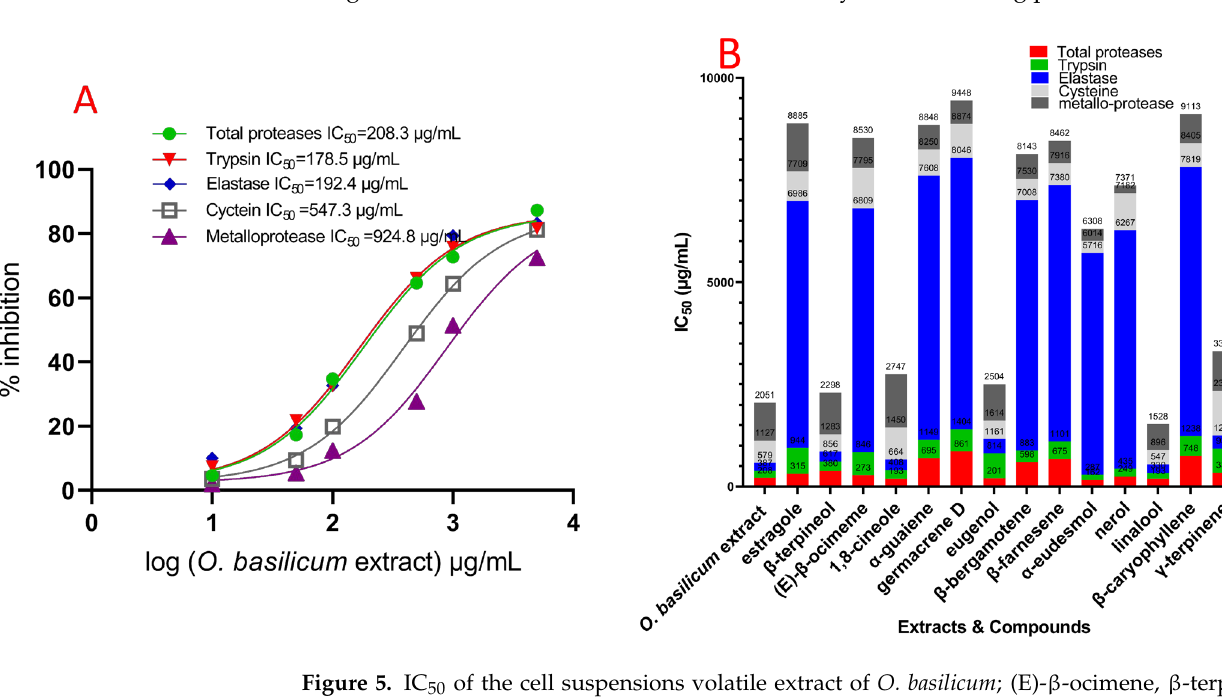
Figure 5. IC 50 of the cell suspensions volatile extract of O. basilicum ; (E)- β -ocimene, β -terpineol, estragole, 1,8-cineole, α -guaiene, germacrene D, β -bergamotene, eugenol, β -farnesene, α -eudesmol, nerol, linalool, β -caryophyllene, and γ -terpinene towards total proteases, trypsin proteinase, chymotrypsin proteinase, elastase, cysteine protease, and metalloprotease (in vivo) of R. ferrugineus midgut. ( A ) Activity and volatile extract’s IC 50 versus proteases enzymes (in vivo) and ( B ) IC 50 of O. basilicum volatile extract and compounds versus proteases enzymes (in vivo) on the enzyme activity data according to one-way analysis of variance (ANOVA).